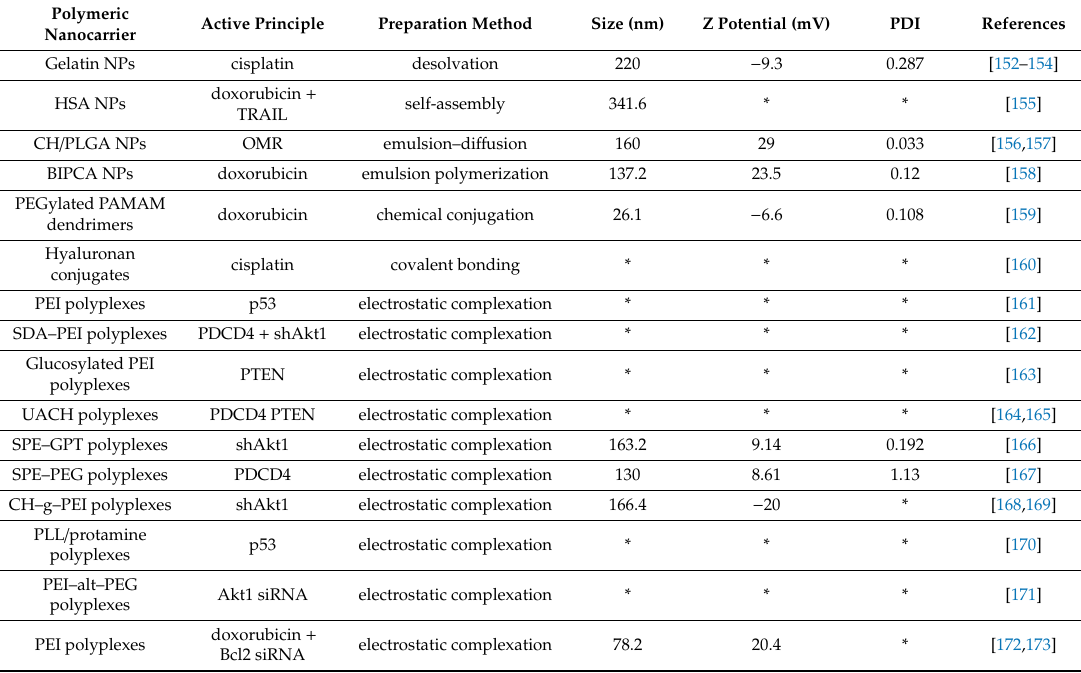
Table 3. Inhalable polymeric